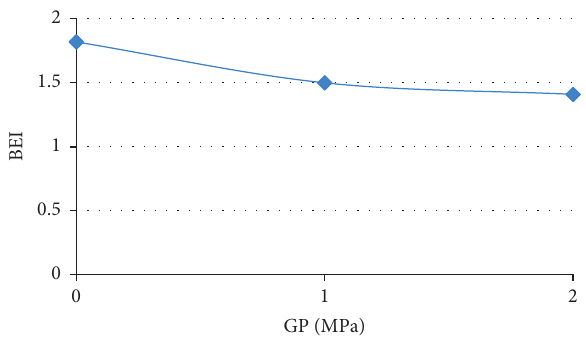
Figure 21: Variation in bump energy index with changing gas pressure.